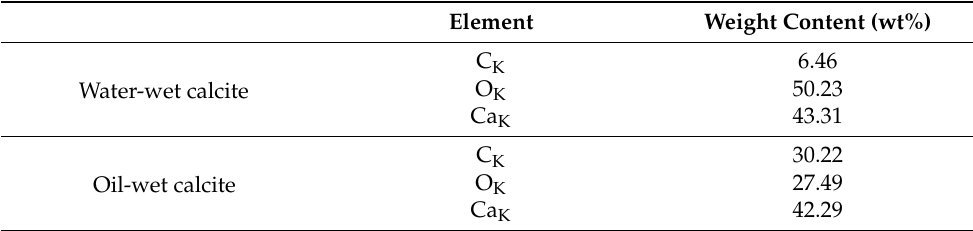
Table 1. SEM–EDS analysis of original water-wet calcite and modified oil-wet